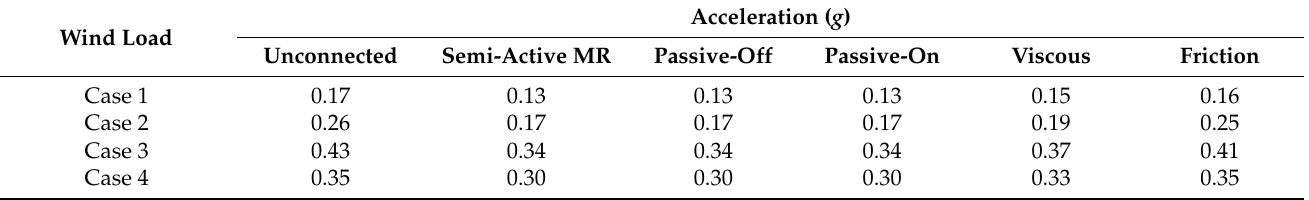
Table 14. Comparison of top storey peak acceleration of the coupled flexible building under different control strategies when dampers are arranged in Configuration